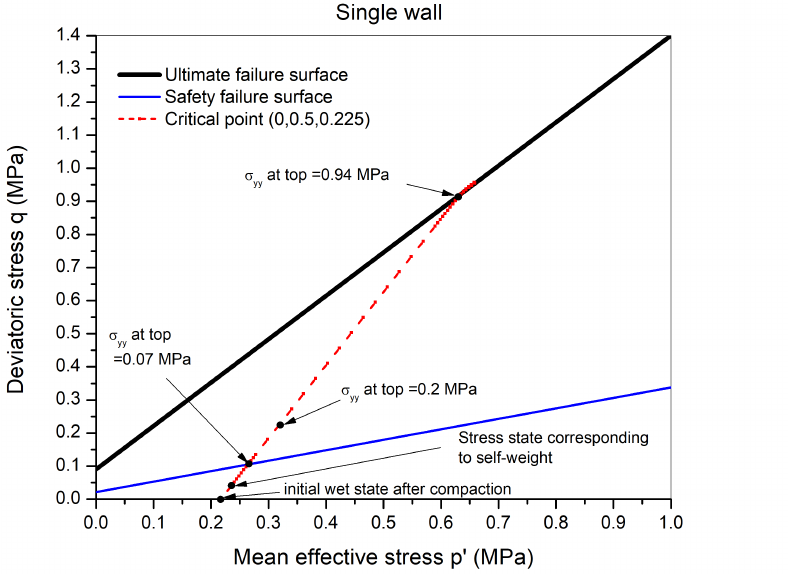
Figure 11. Stress path for single wall at the critical point due to vertical stress at top starting from optimum compaction hydric